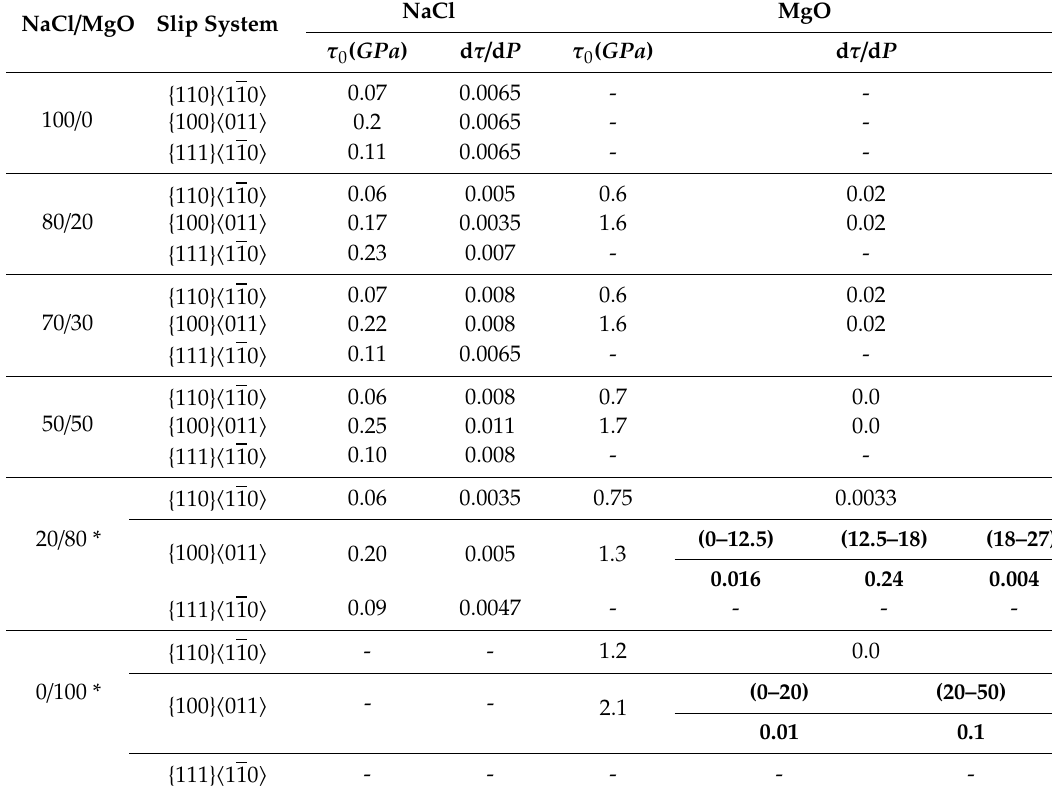
Table 1. Critical resolved shear stress (CRSS) values used in elasto-viscoplastic self-consistent (EVPSC) modeling.